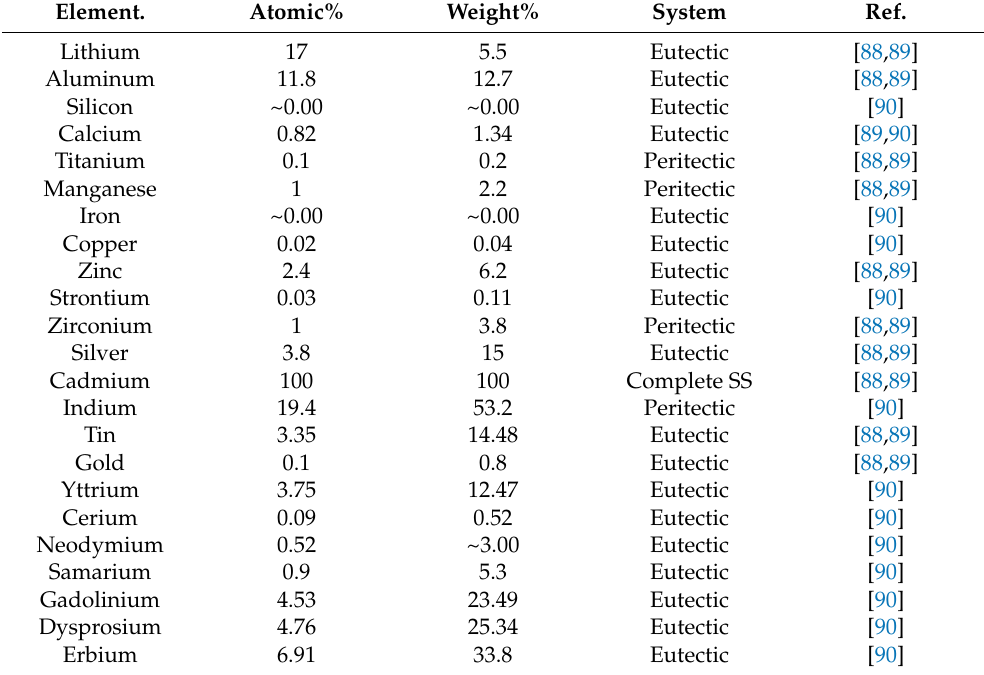
Table 1. Solubility data for binary Mg-based alloys [88–90] . Element.